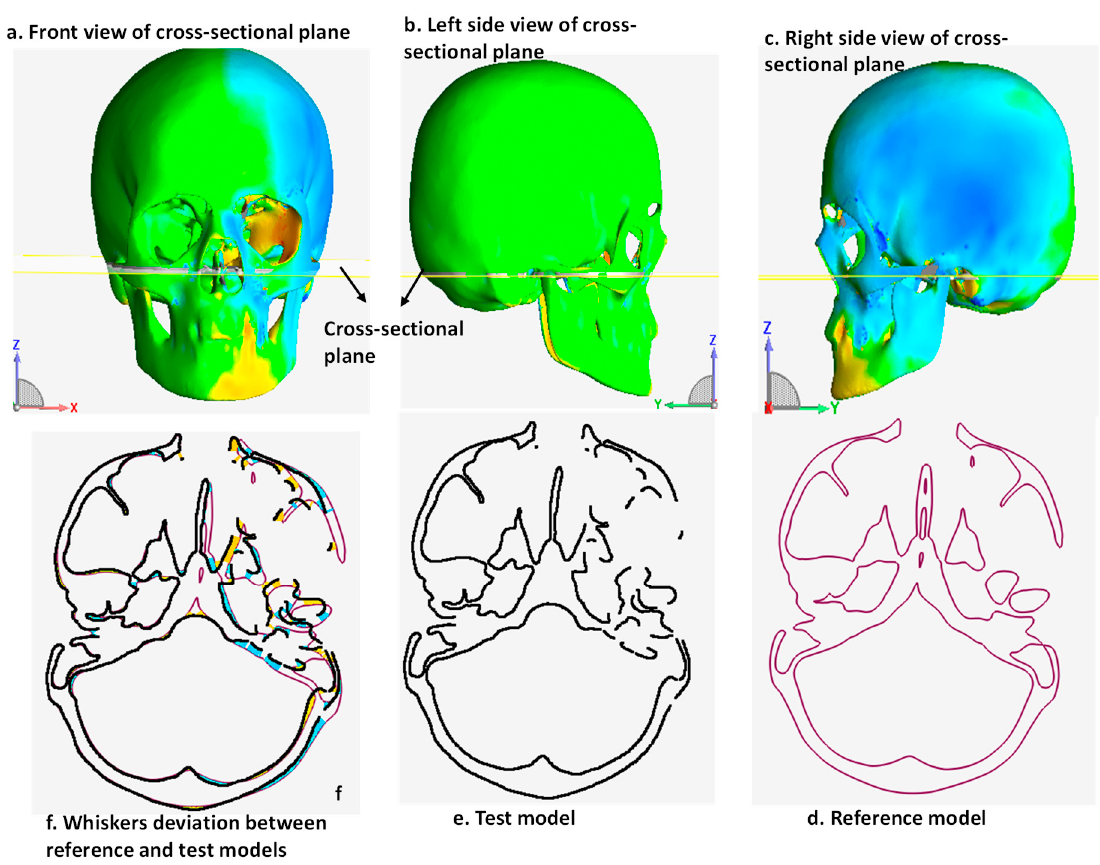
Figure 13. Different views ( a – c ) of cross-sectional plane on the implant region. The 2D comparison results ( f ) illustrating the deviation between the ( d ) reference model and the ( e ) test model.